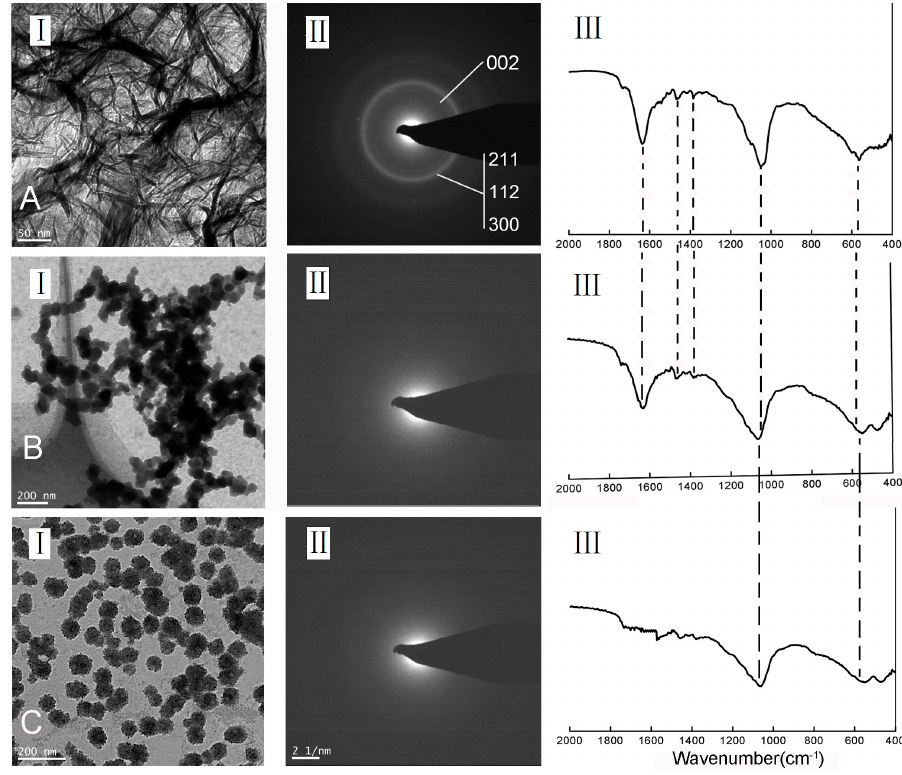
Figure 3. Unstained TEM images ( I ) and selected area electron diffraction (SAED) patterns ( II ), as well as the ATR-FTIR ( III ) of calcium phosphate minerals formed in the presence of 0.4 mM EHBP ( A ); 0.4 mM ELBP ( B ) and RP ( C ).